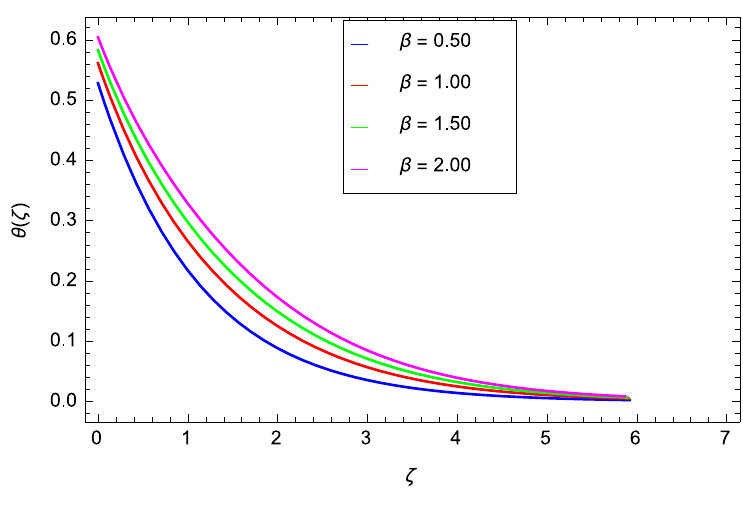
Figure 6. Influence of β on θ ( ζ ) .